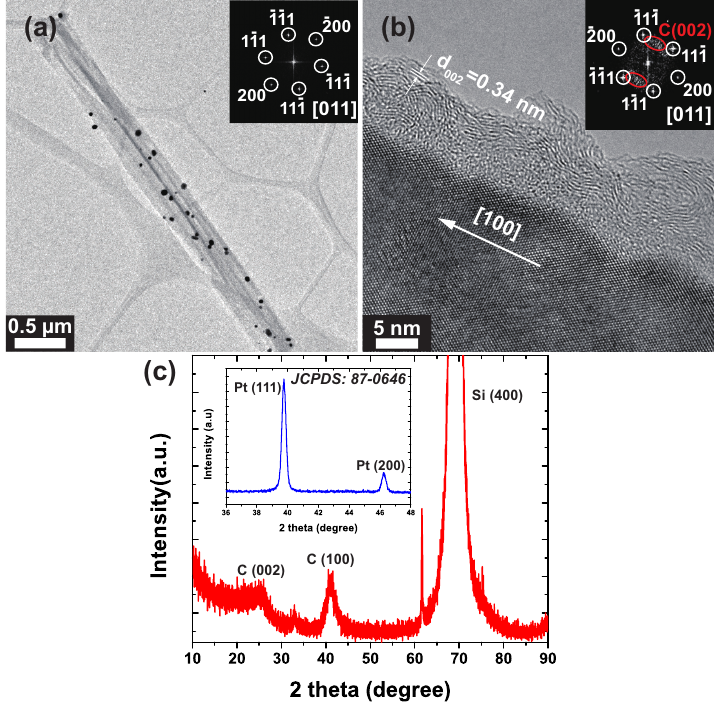
Figure 2. ( a ) Low-resolution transmission electron microscopy image of SiNW/C@Pt (inset: fast Fourier-transformed electron diffraction (FFT-ED) pattern of platinum nanoparticles, Pt NPs); ( b ) high-resolution image of SiNW/C with no Pt NPs (inset: FFT-ED pattern of SiNW/C); and ( c ) XRD pattern of SiNW/C (inset: XRD pattern of Pt